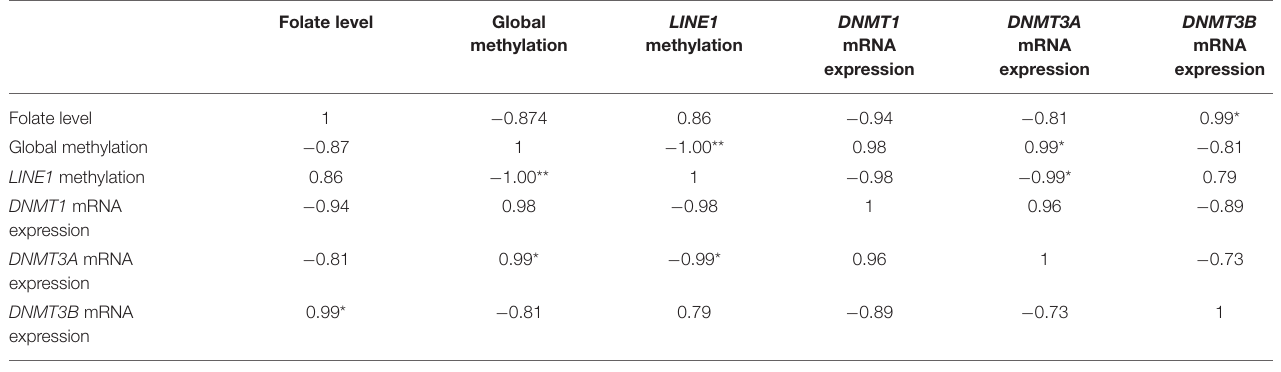
TABLE 2 | Correlation analysis of mRNA expression of various DNMTs, folate level, and global methylation level in JEG-3 cells upon folic acid supplementation.